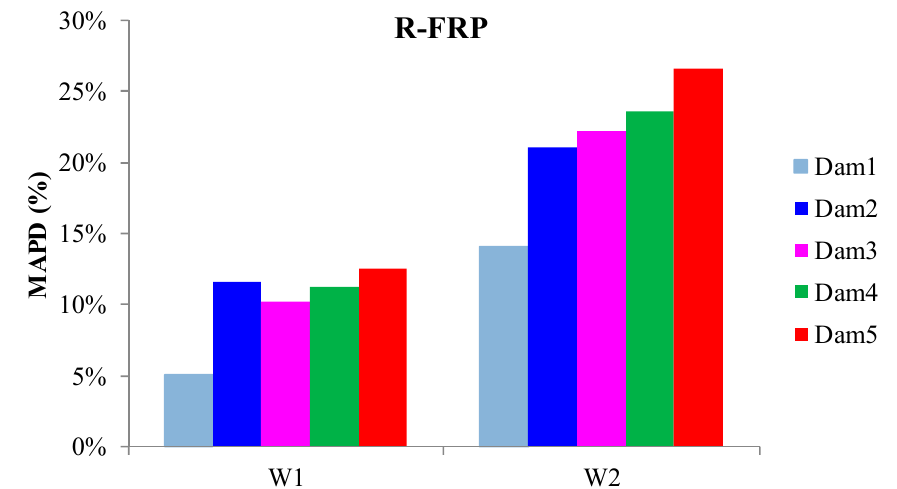
Figure 22. MAPD index values of PTZs mounted on the C-FRP rope of R-FRP.